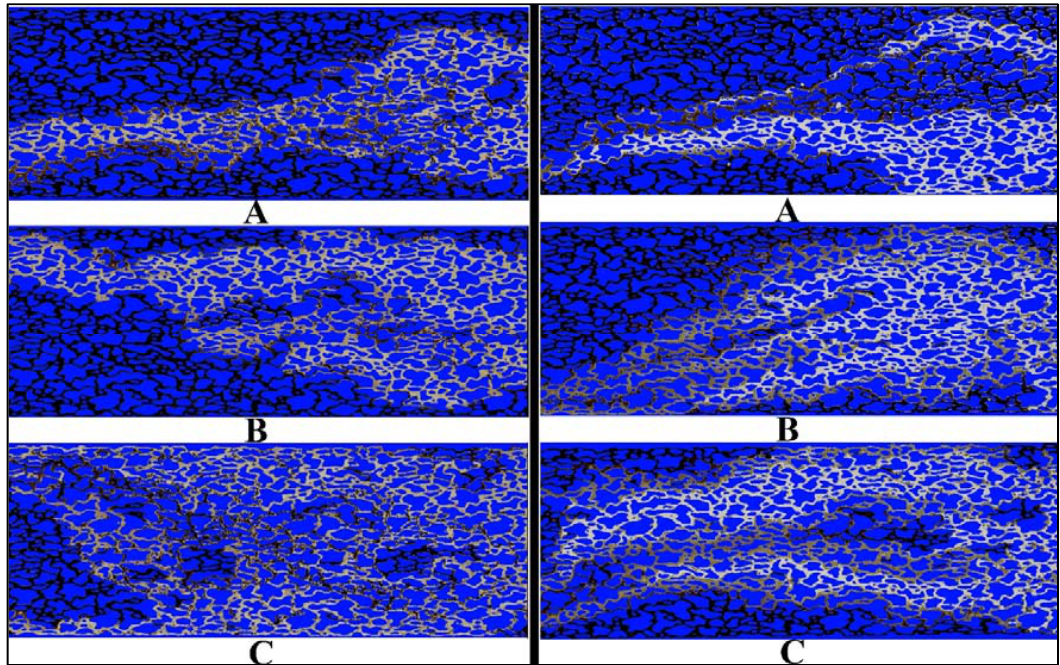
Fig. 7. Macroscopic photos of ultimate recovery for n-hexane (left) and gas condensate (Right) base fluid: A) 0 wt.%, B) 3 wt.% and C) 5 wt.% of silica